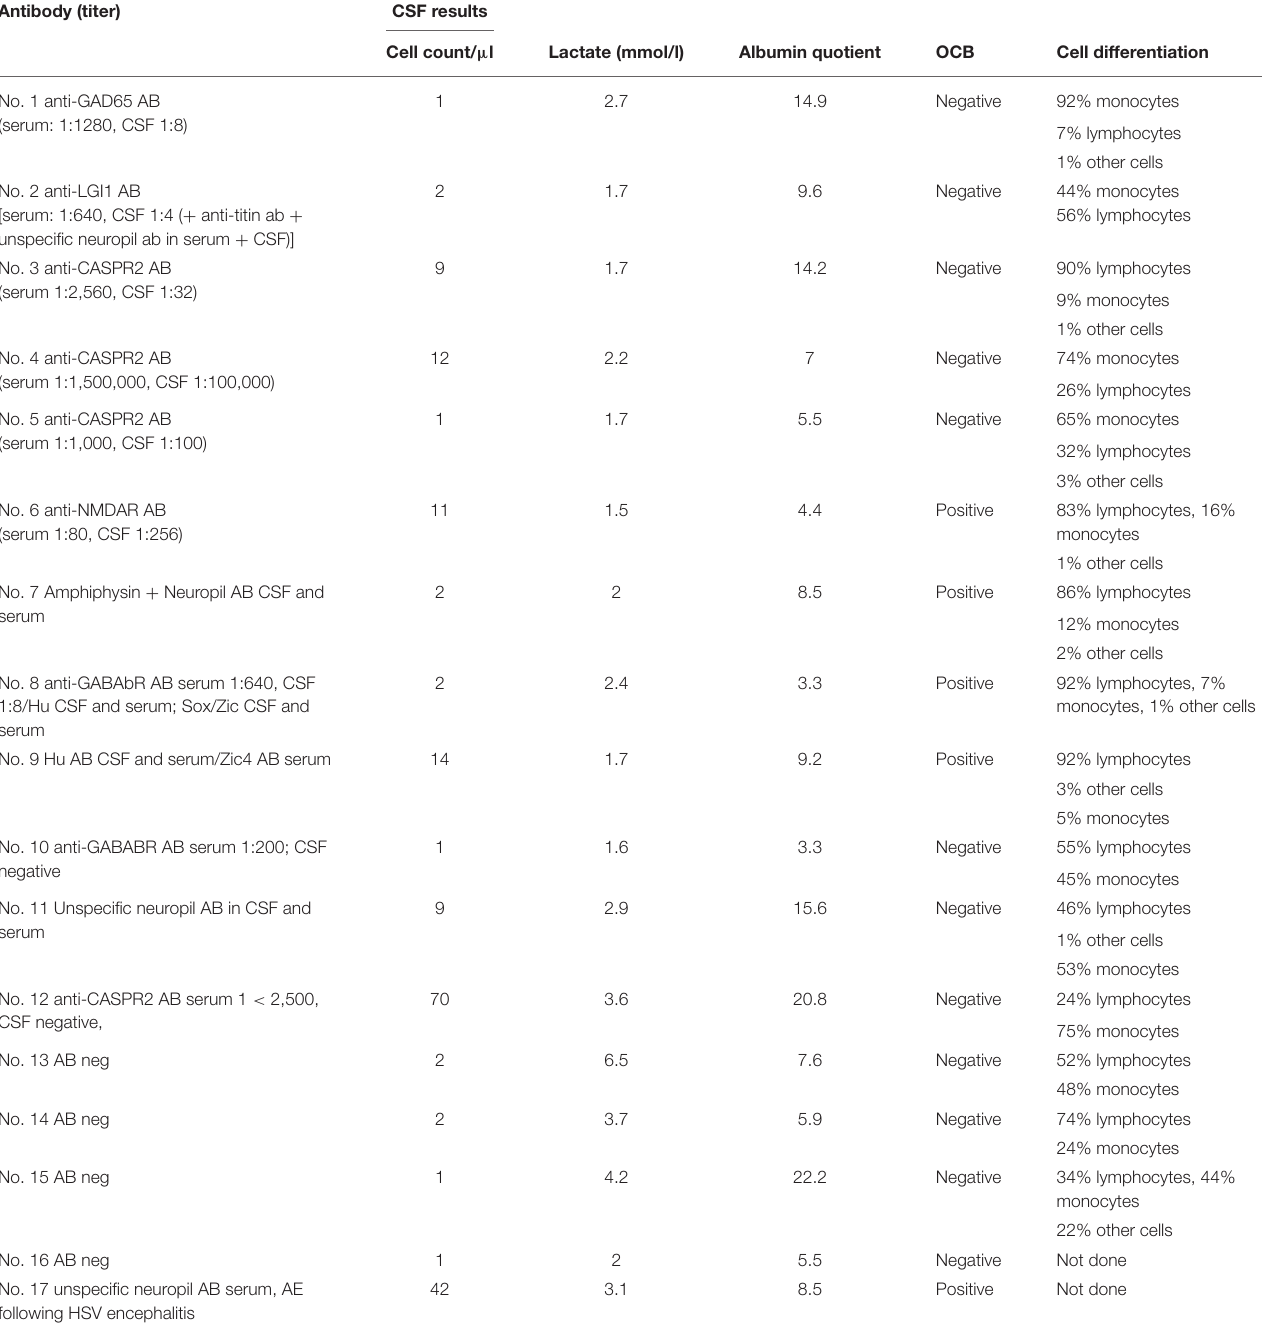
TABLE 2 | Neural antibody and CSF results of patients with definite and suspected AE. Antibody (titer) CSF results Cell count/ µ l Lactate (mmol/l) Albumin quotient OCB Cell